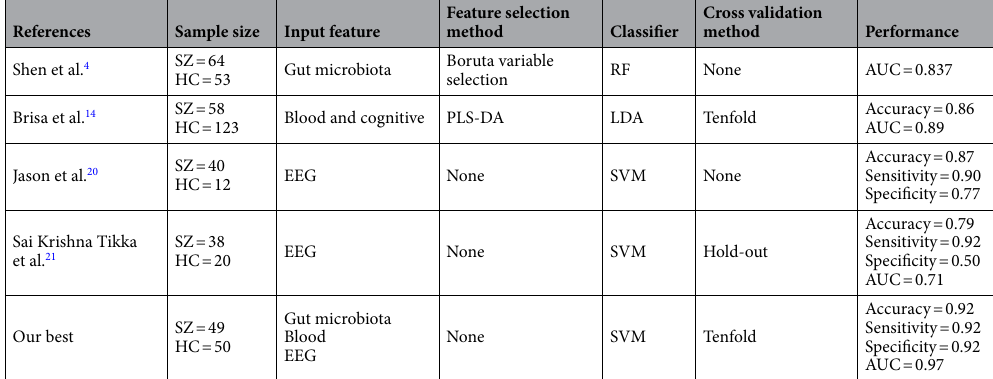
Table 4. Comparison of classification performance with existing research. RF random forest, PLS-DA partial least squares discriminant analysis, LDA linear discriminant analysis, EEG electroencephalogram, SVM support vector machine, AUC area under the receiver operating characteristic